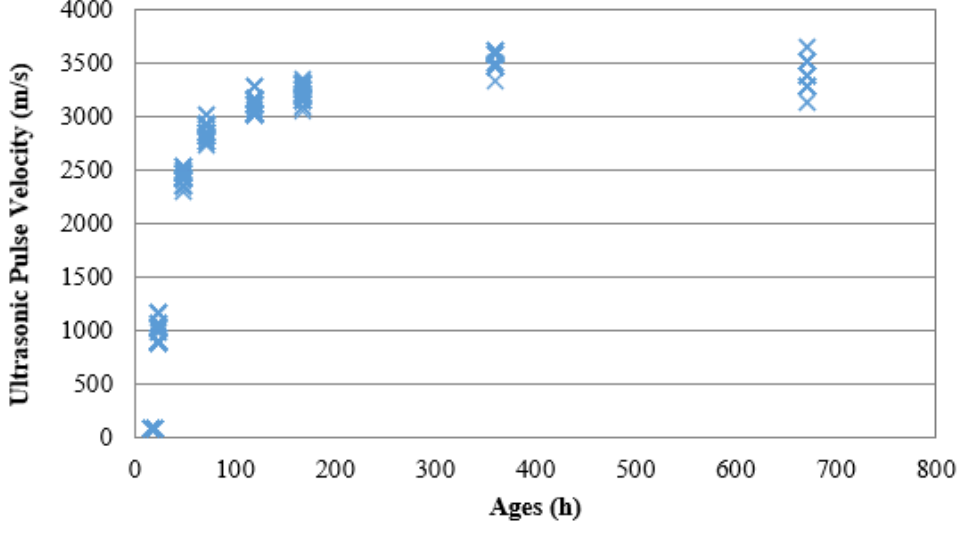
Figure 7. Ultrasonic pulse velocity with age (30 MPa).